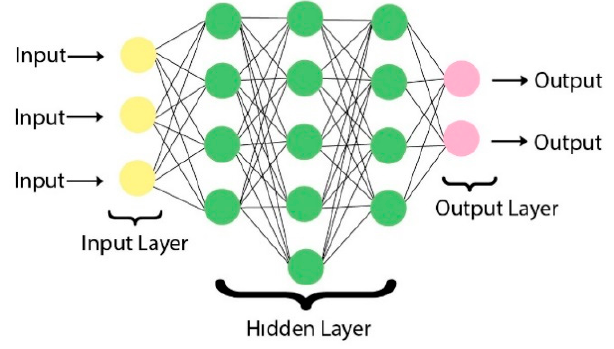
Figure 6. Feed-Forward Neural Network Architecture.